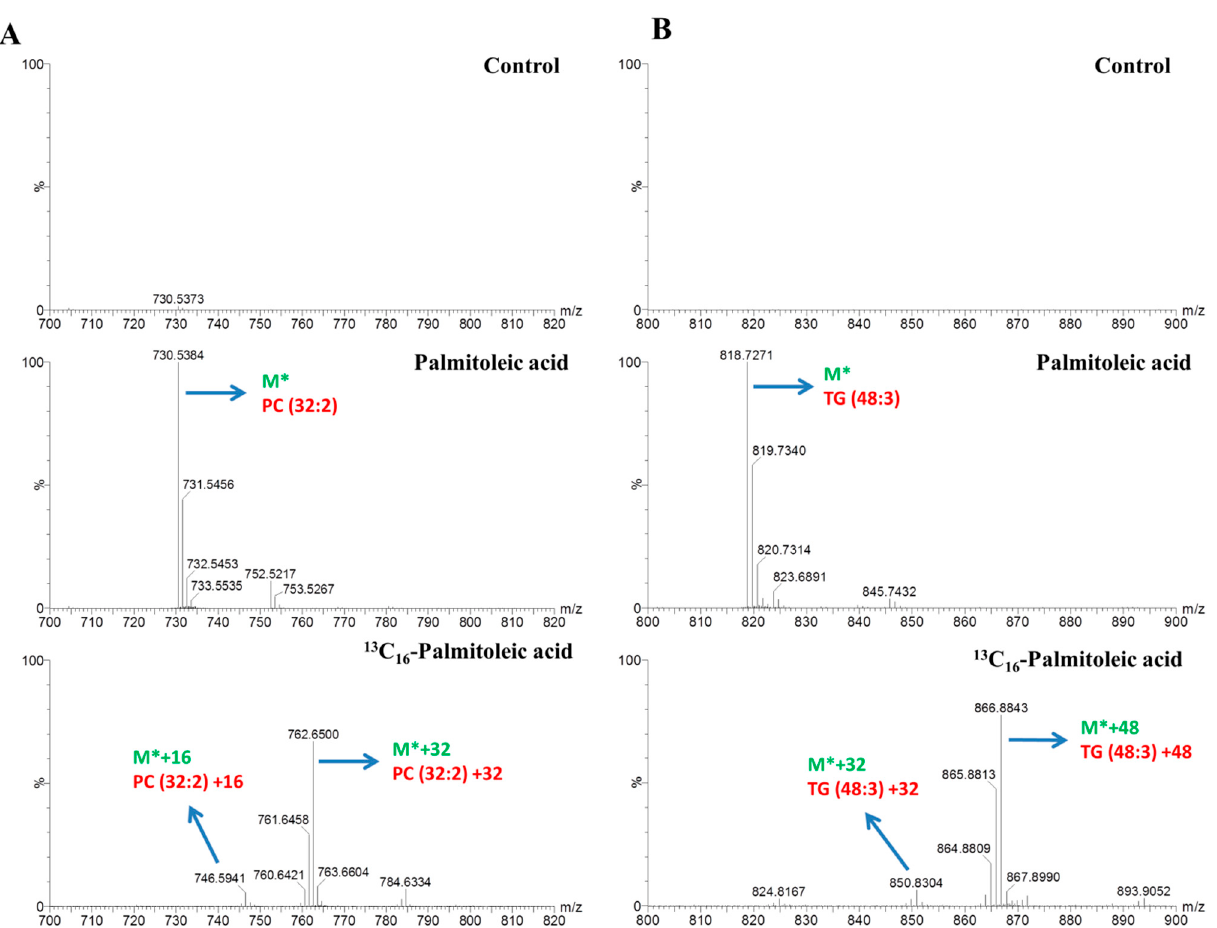
Figure 3. Illustration of the stable isotope-labeled C16:1 metabolite mass spectrum. ( A ) The peaks of PC (32:2) (M*) and its isotopomers (M* + 16 or M* + 32) detected in HepG2 cells incubated with 0.3 mM palmitoleic acid and 13 C16-labeled palmitoleic acid, respectively, after16-h treatment. ( B ) The peaks of TG (48:3) (M*) and its isotopomers (M* + 16 or M* + 48) detected in HepG2 cells incubated with 0.3 mM palmitoleic acid and 13C16-labeled palmitoleic acid, respectively, after 16-h treatment. M* means the m / z in positive or negative mode.